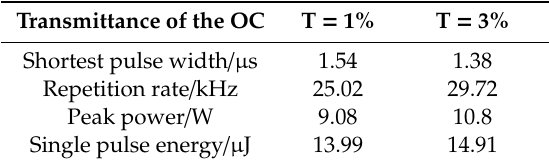
Table 1. Performances of the PQS Ho: YLF laser under different OCs.